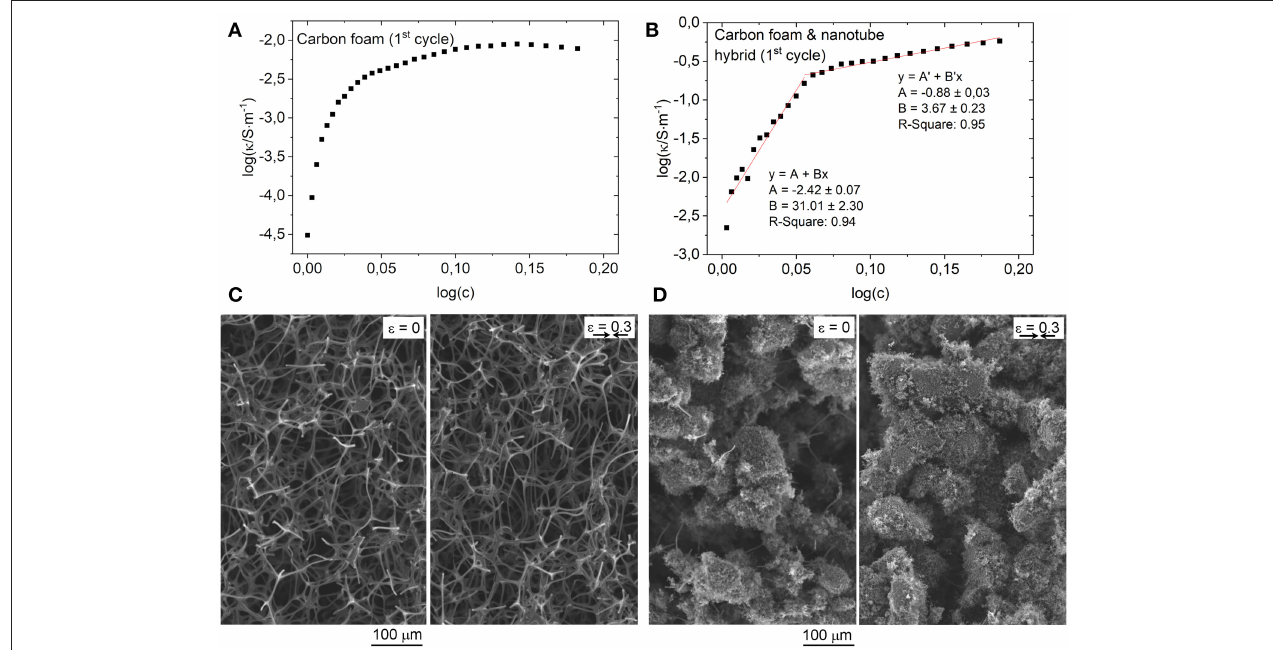
FIGURE 4 | Double logarithmic plots of the electrical conductivity and concentration (strain dependent inverse volume) for (A) carbon foam and (B) carbon foam and carbon nanotube hybrid structures. The plots are derived from the first compression cycle data of electrical resistance vs. mechanical stress in Figures 2A,B . Scanning electron micrographs of (C) carbon foam and (D) composite foam without and with uniaxial